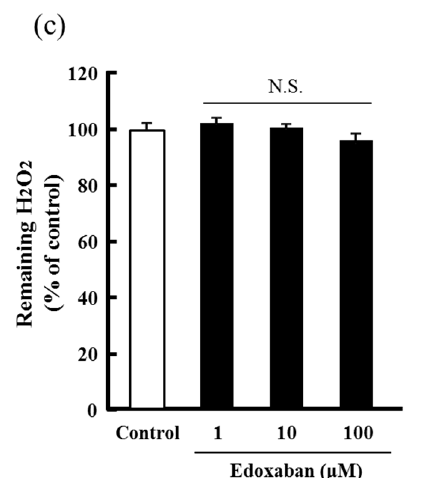
Figure 3. Effect of edoxaban on hydroxyl radical scavenging activity and hydrogen peroxide decomposition. ( a ) Electron spin resonance spectrum of 5,5-Dimethyl-1-pyrroline- N -oxide (DMPO)-OH signal in the reaction between DMPO and • OH. ( b ) Quantitation of • OH remaining. ( c ) Quantitation of H 2 O 2 remaining. Values are expressed as the mean ± S.D. ( n = 3). ** p < 0.01 vs. control. N.S.: not significant, VC: Vitamin C.